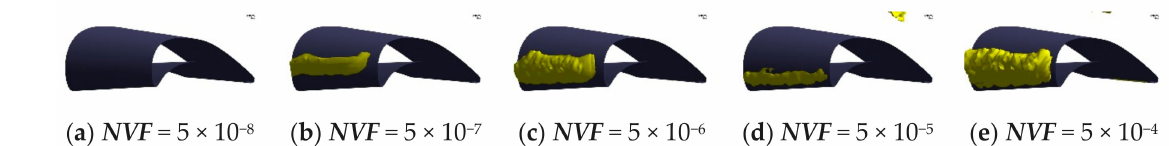
Figure 15. The 10% vapor volume fraction distribution in stator domain at stall under various nuclei volume fractions.